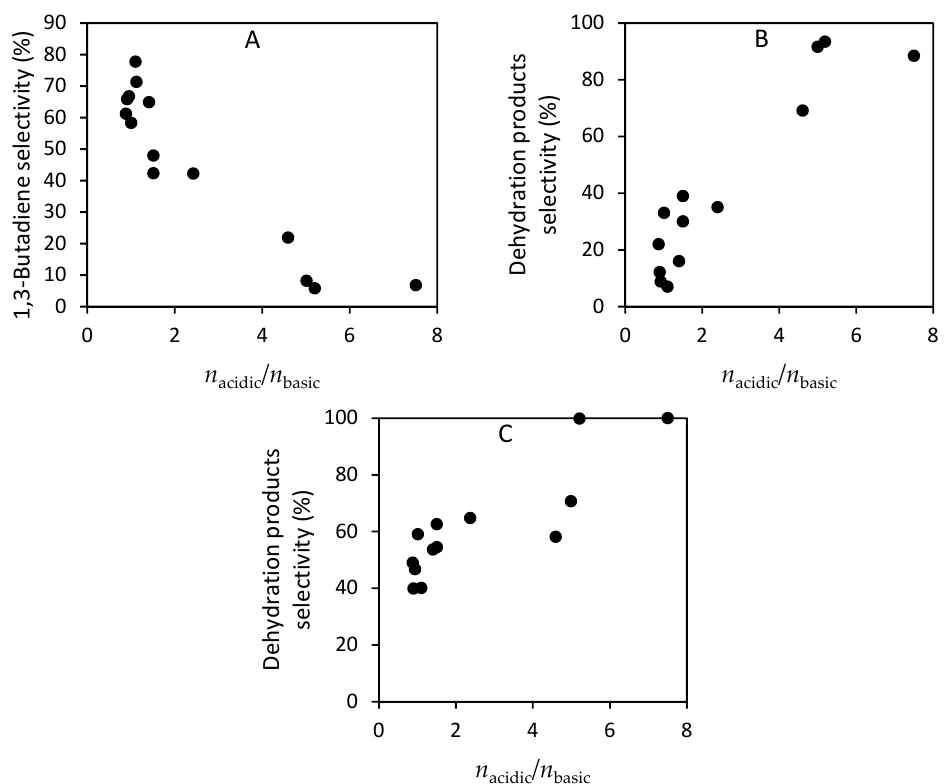
Figure 13. Correlation curves between the ratio between the number of acid and basic sites with: ( A ) 1,3-butadiene selectivity; ( B ) dehydration products selectivity; ( C ) ethanol conversion. Reprinted with permission from [60]. Copyright 2015, Elsevier.